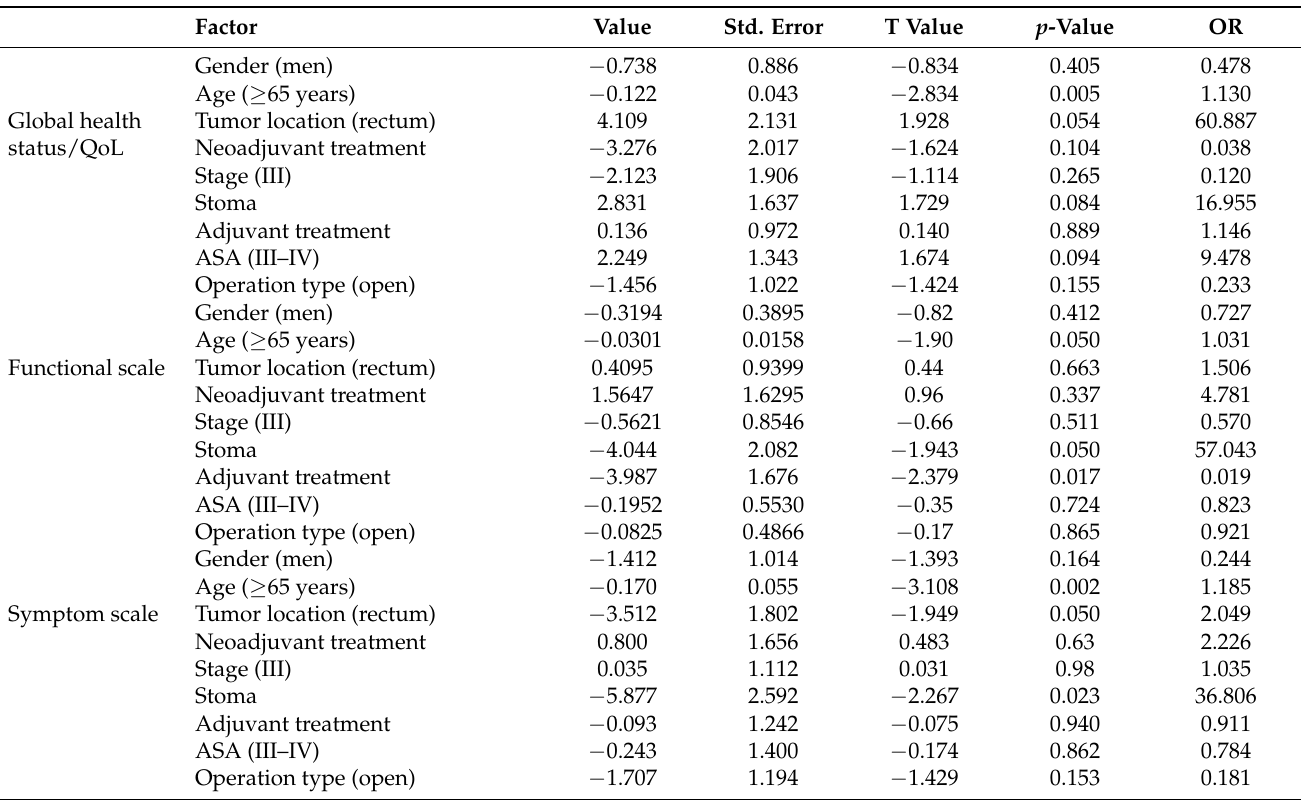
Table 2. Multivariate analysis of factors predicting poorer quality of